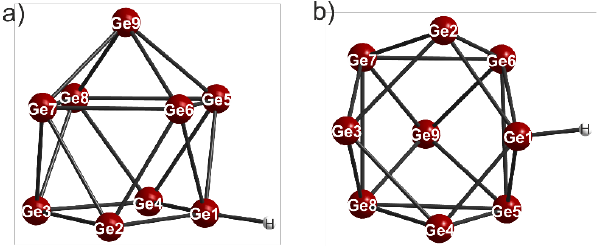
Figure 1. ( a , b ) Two different views of the anionic part of the compound [Rb([2.2.2]crypt)] 2 [Rb([18]crown − 6)][HGe 9 ] · 4NH 3 . Crystals 2018 , 8 , x FOR PEER REVIEW Table 2. Distances [Å ] within the anionic moiety [HGe 9 ] 3− .